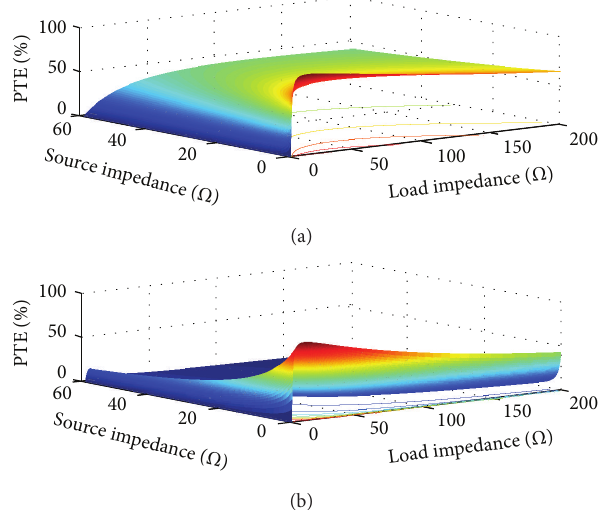
Figure 10: PTE versus source and load impedances. (a) DCR configuration scenario A. (b) DCR configuration scenario